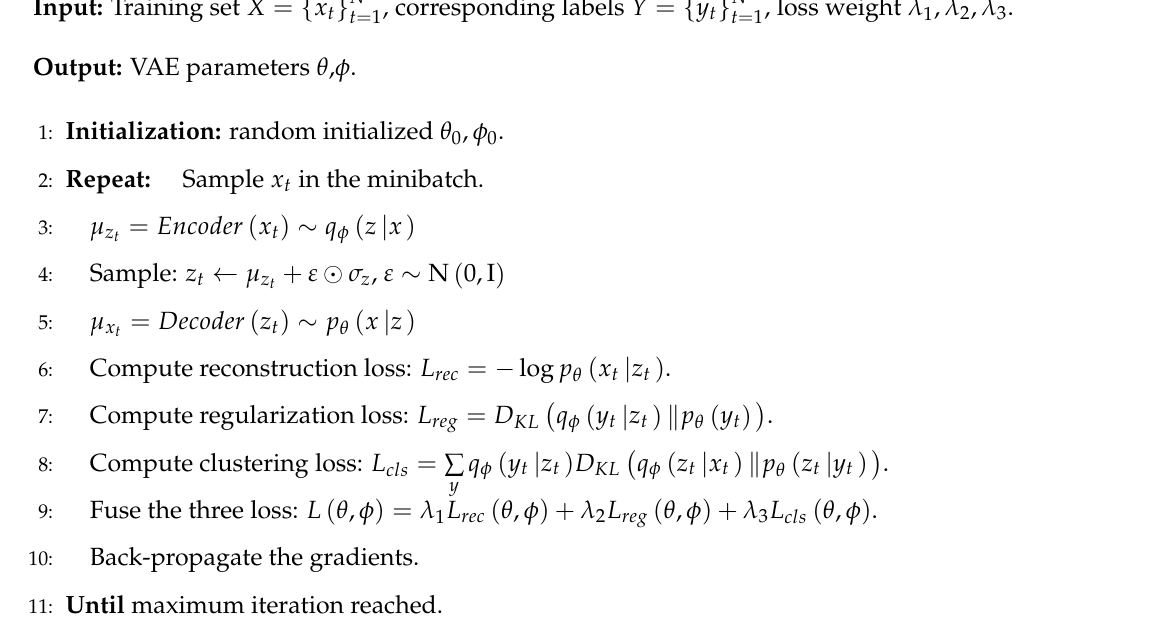
Algorithm 1 Variational Autoencoder